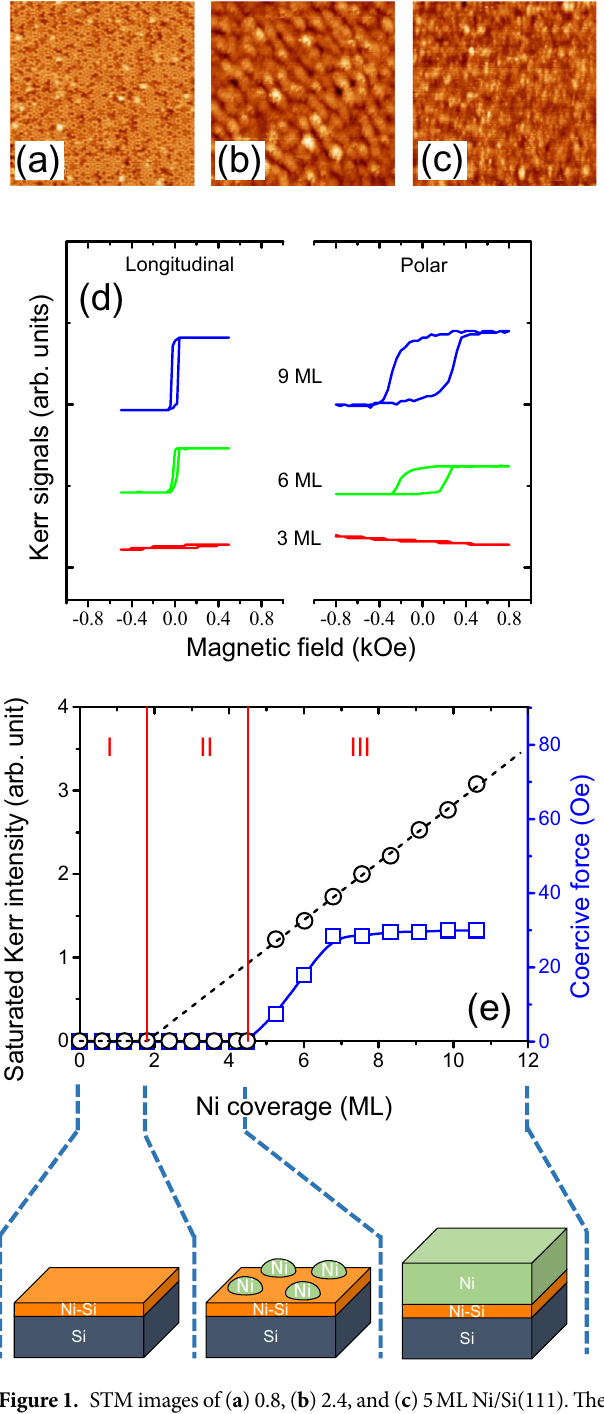
Figure 1. STM images of ( a ) 0.8, ( b ) 2.4, and ( c ) 5 ML Ni/Si(111). The images sizes are 50 × 50 nm 2 . ( d ) Kerr signals versus the magnetic field for 3, 6 and 9 ML Ni/Si(111) in both the longitudinal and polar configurations. ( e ) Saturated Kerr intensity and coercive force versus Ni coverage in the longitudinal configuration. The different regimes are characterized by different magnetic behaviors. They are composed of nonmagnetic silicides, clusters with lowered Curie temperature, and ferromagnetic films, as illustrated at the bottom of the